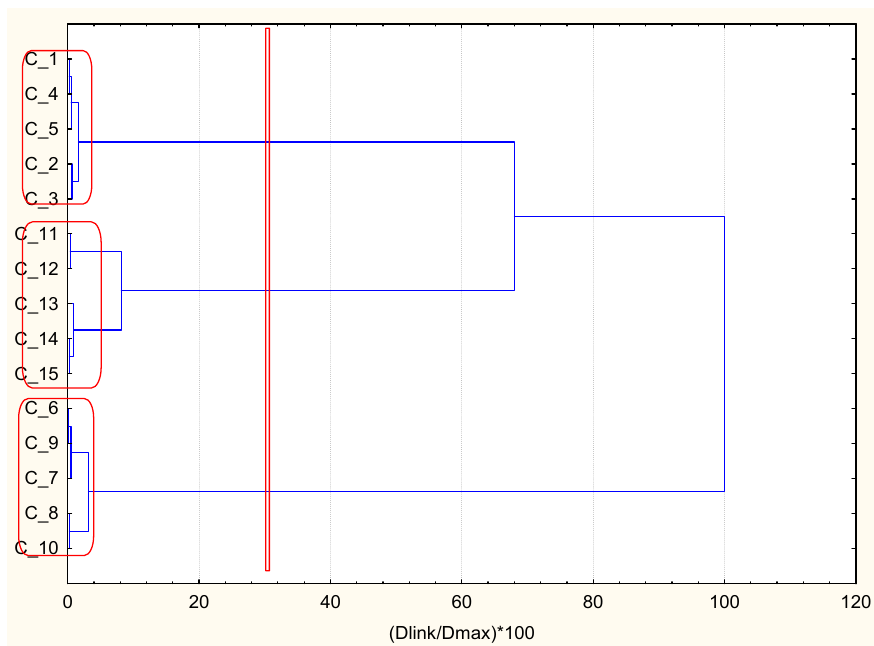
Figure 3. Hierarchical dendrogram for clustering of 15 occasionally selected patients with DMT2 and CHD as underlying diseases.